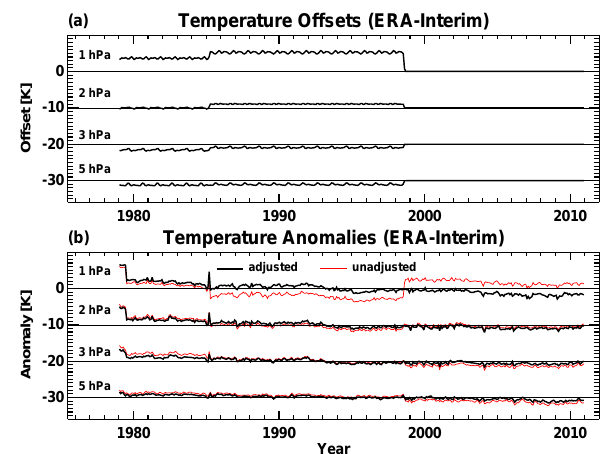
Fig. 3. Global mean 6-hourly ERA-Interim temperatures at 1hPa showing the jumps in (a) March 1985 and (b) August 1998: adjusted (blue) and unadjusted (red). The jump times (12:00UTC 21 March 1985 and 00:00UTC 1 August 1998) are denoted by the left pair of thin vertical lines. The second pair of vertical lines, which are 10 days after the jump times, are shown in order to indicate the timescale of the transition after the jumps.